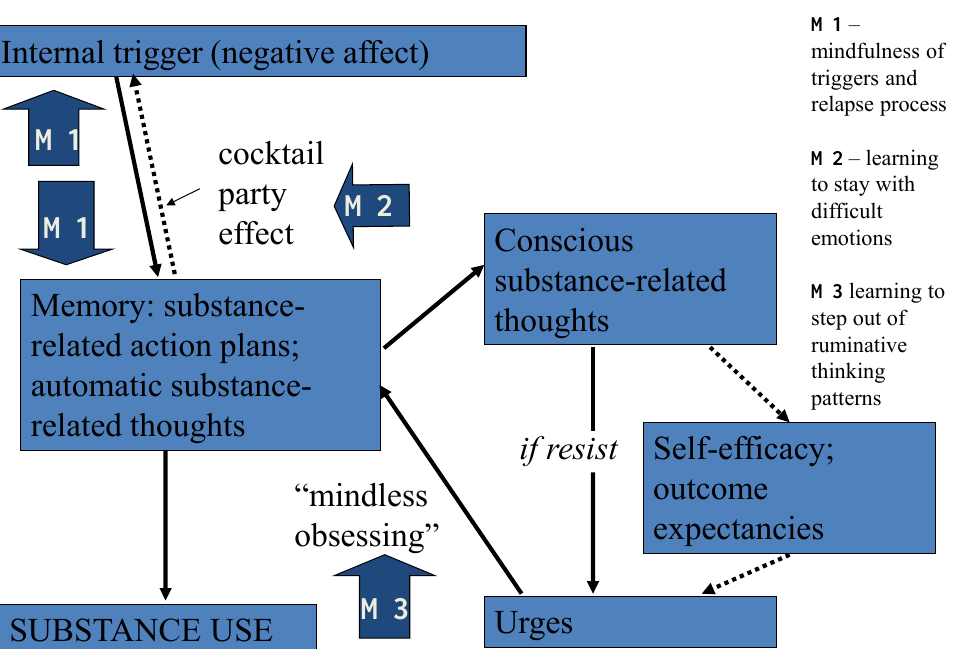
Figure 1. Relapse process and potential modification by